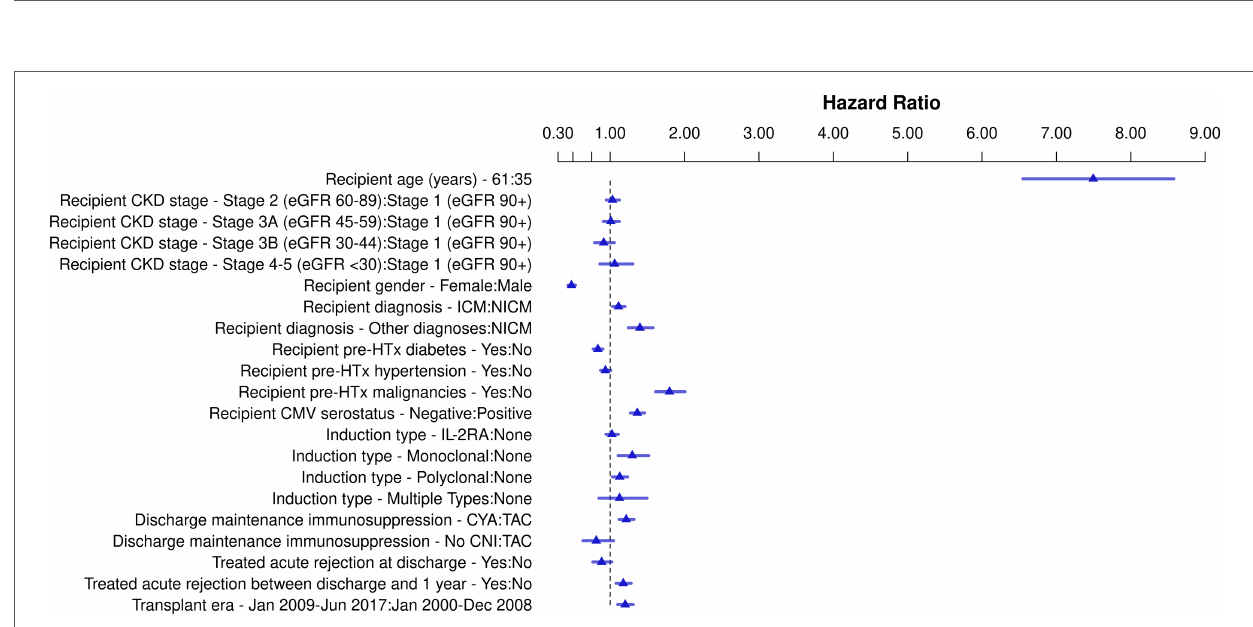
FIGURE 4 Schematic overview for risk factors for post-transplant lymphoproliferative disease post-heart transplant. Hazard ratios for continuous variables are shown for the third quartile vs. the fi rst quartile. Abbreviations: CKD, chronic kidney disease; CMV, cytomegalovirus; EBV, Epstein Barr virus; eGFR, estimated glomerular fi ltration rate; HTx, heart transplantation; ICM, ischemic cardiomyopathy; NICM, non-ischemic cardiomyopathy.